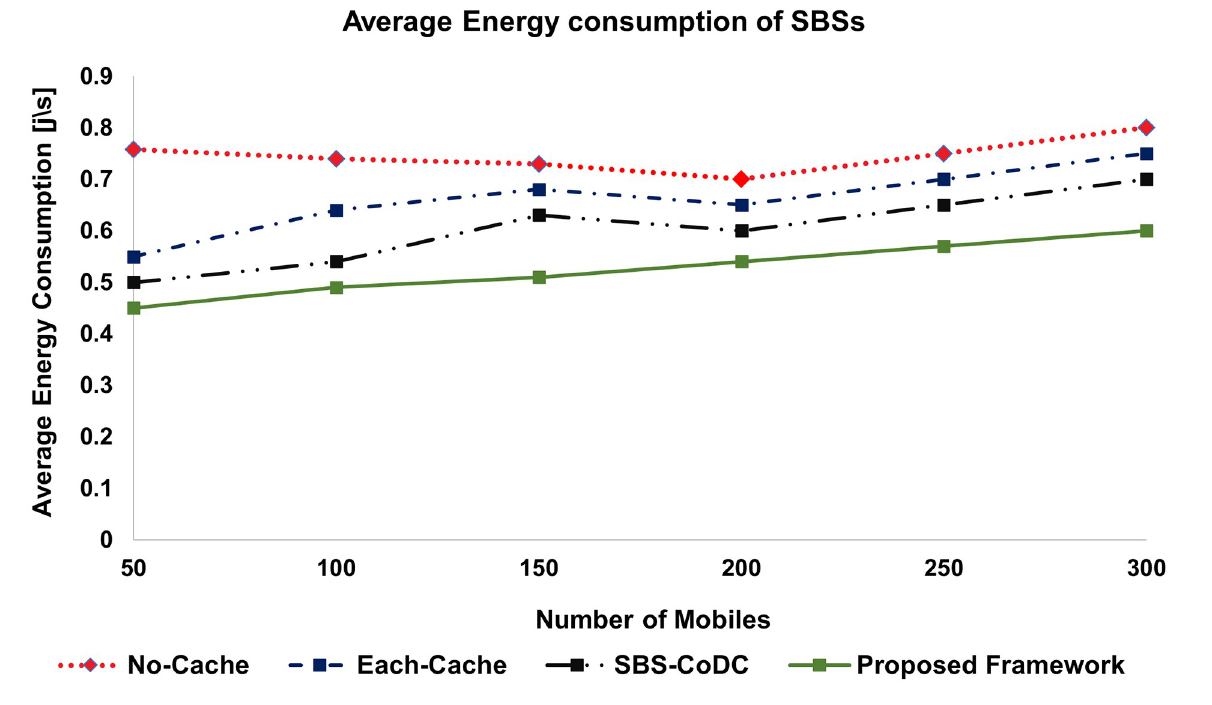
Fig 7. Comparison average energy consumption of SBSs.